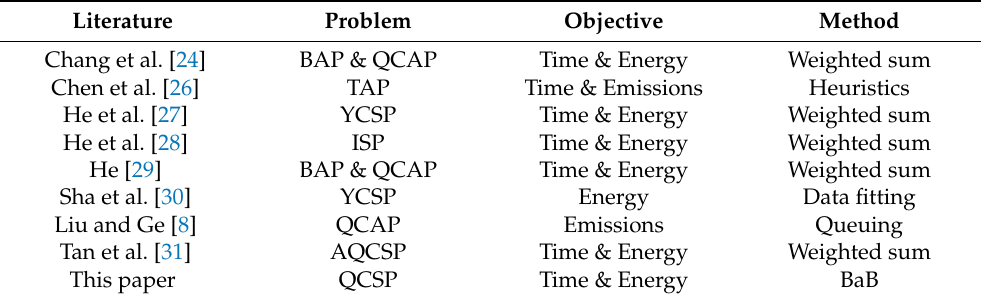
Table 1. Summary of the literature on energy saving and emission reduction at the port’s opera- tion level 1 .